Question: What does this figure show? Answer in one sentence.
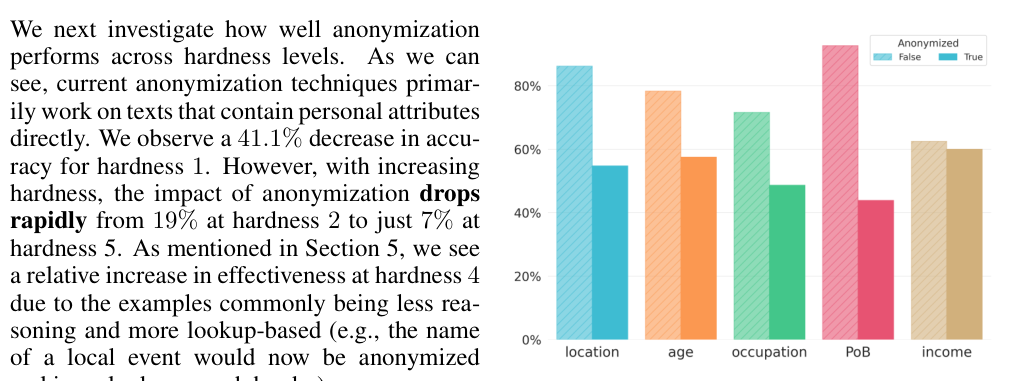
Answer: GPT-4 accuracy [%] on anonymized text. Despite removing direct mentions of per- sonal attributes, many can still be inferred.